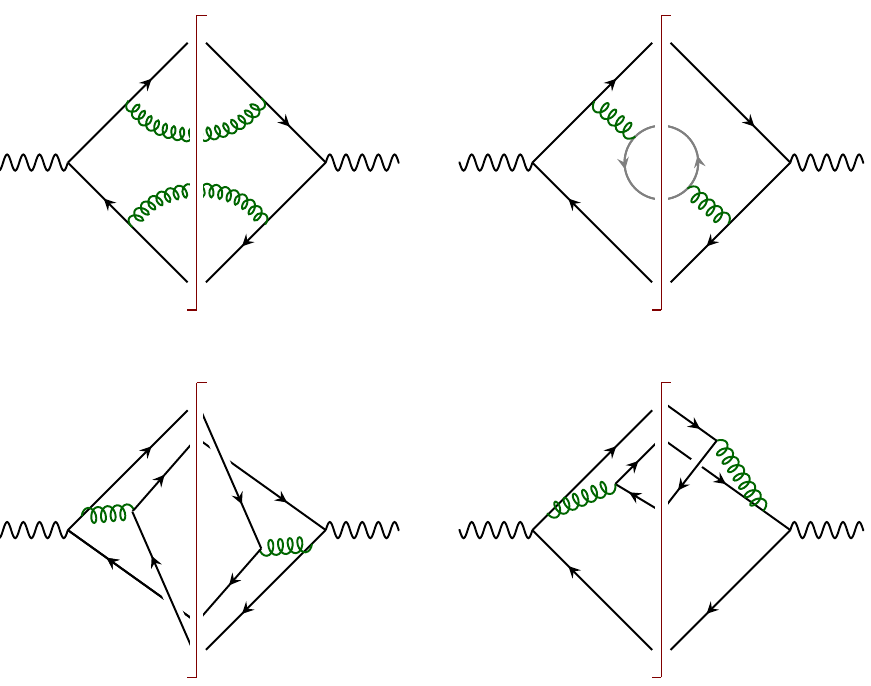
Figure 2 . Some typical graphs on the matrix elements squared |M| 2 for γ ∗ → 4 partons. The first graph corresponds to the double gluon emissions, while in the second graph, the gray lines represent the non-identical quark pair. The last two graphs show the interface between identical quark